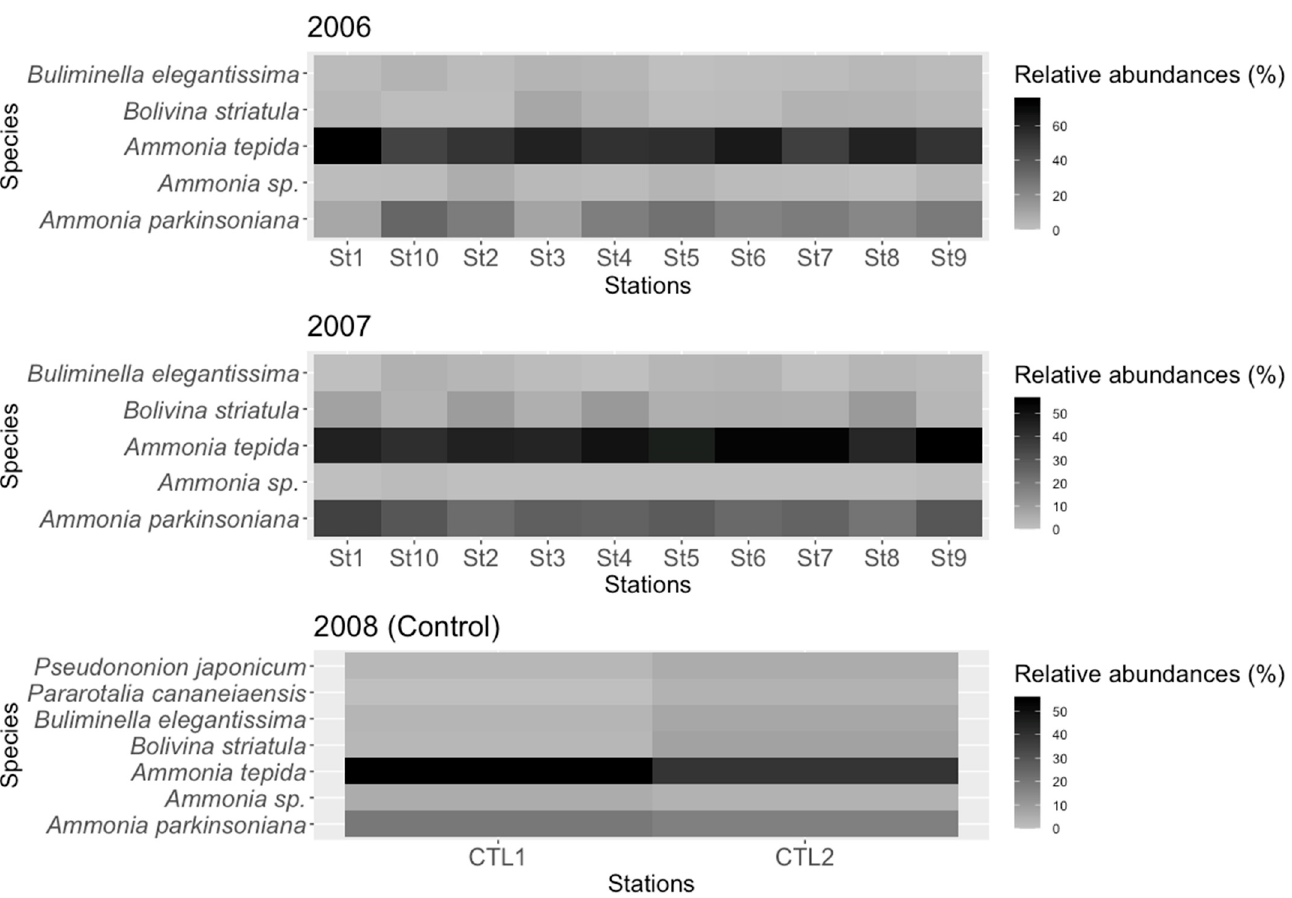
Figure 4. Heatmap showing the spatial and temporal distribution patterns of the main species (relative abundances >4%).